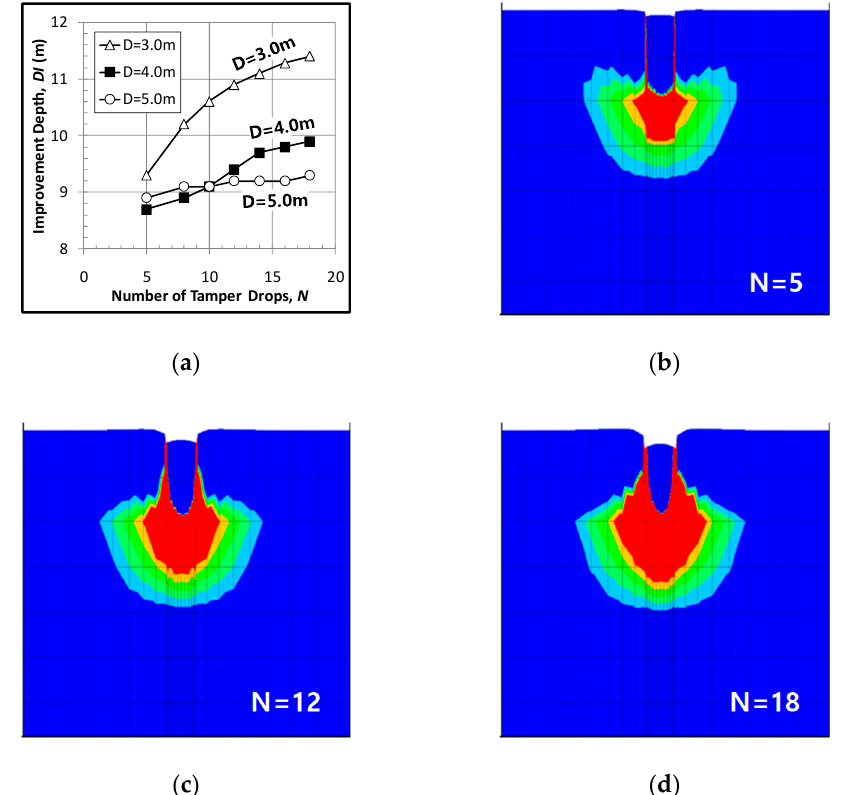
Figure 11. Volumetric strain increment with increase in number of drops (D = 4 m, W = 20 tons, H = 15 m): ( a ) improvement depth, DI , increase with N; ( b ) Δε v contour for N = 5; ( c ) Δε v contour for N = 12; ( d ) Δε v contour for N = 18.